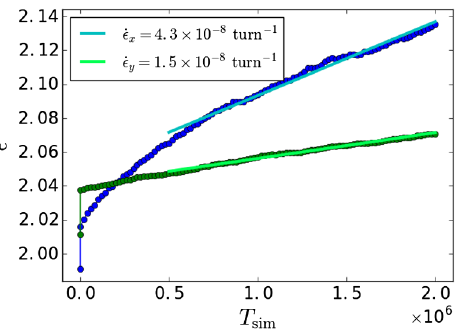
FIG. 4. Example of evolution of beam emittance in both transverse planes, ϵ x and ϵ y . The beam emittances are given based on normalized coordinates, being ϵ ¼ 2 for a perfect initial Gaussian distribution. The straight lines represent the linear regressions giving the emittance growth rates.